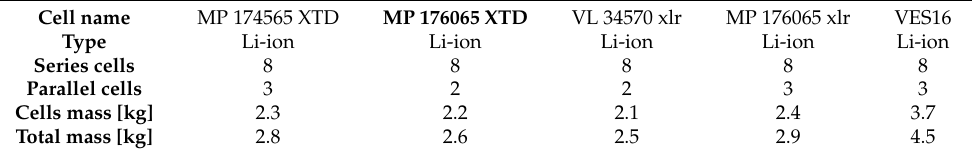
Table 6. Required number of rechargeable battery cells (series and parallel), cells’ mass and total mass of the battery module (including the mechanical assembly and electrical